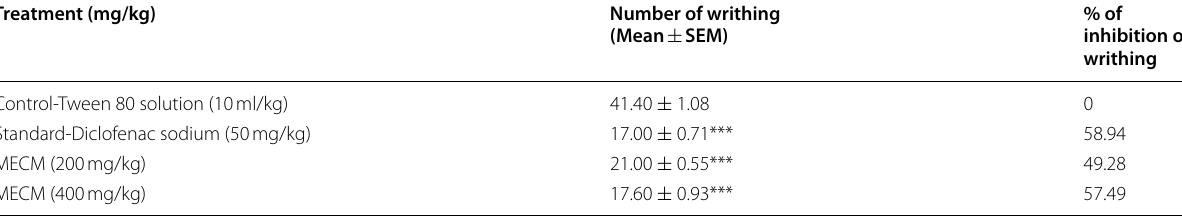
MECM Methanolic extract of seeds, SEM Standard error of the mean All values are expressed as Mean ** p < 0.01, *** p < 0.001 were considered statistically significant compared to control